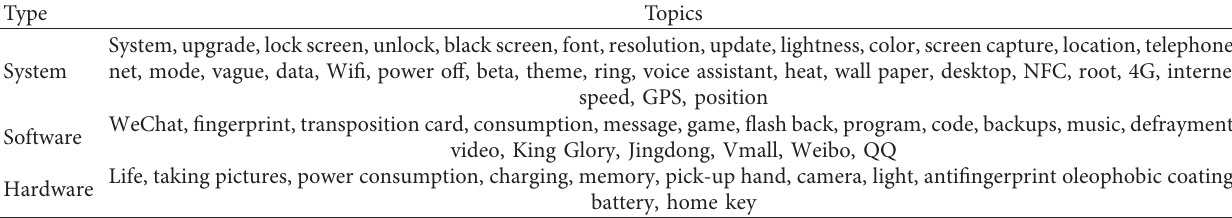
Table 2: Classification of topics.